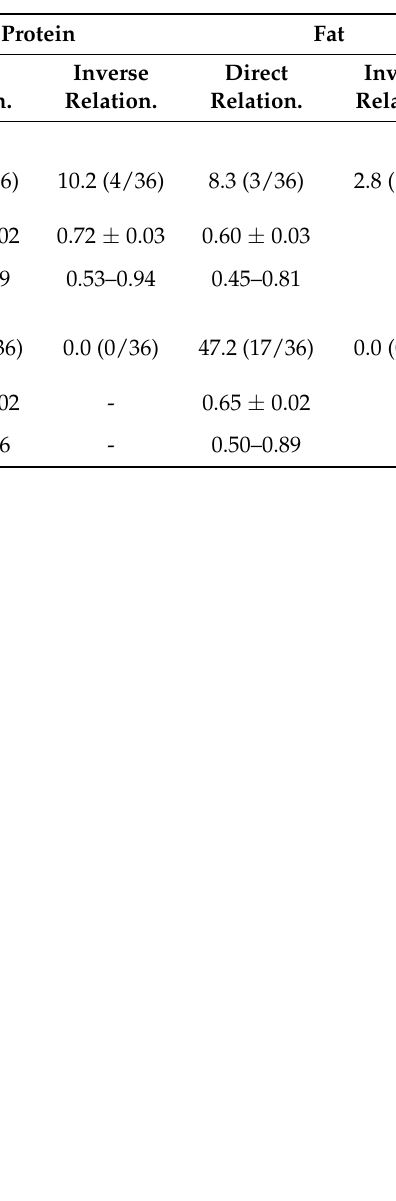
Table 4. Number of significant relationships (direct and inverse) between glucagon and glucose, and glucagon and insulin, in different metabolic tests. R 2 values are also reported.